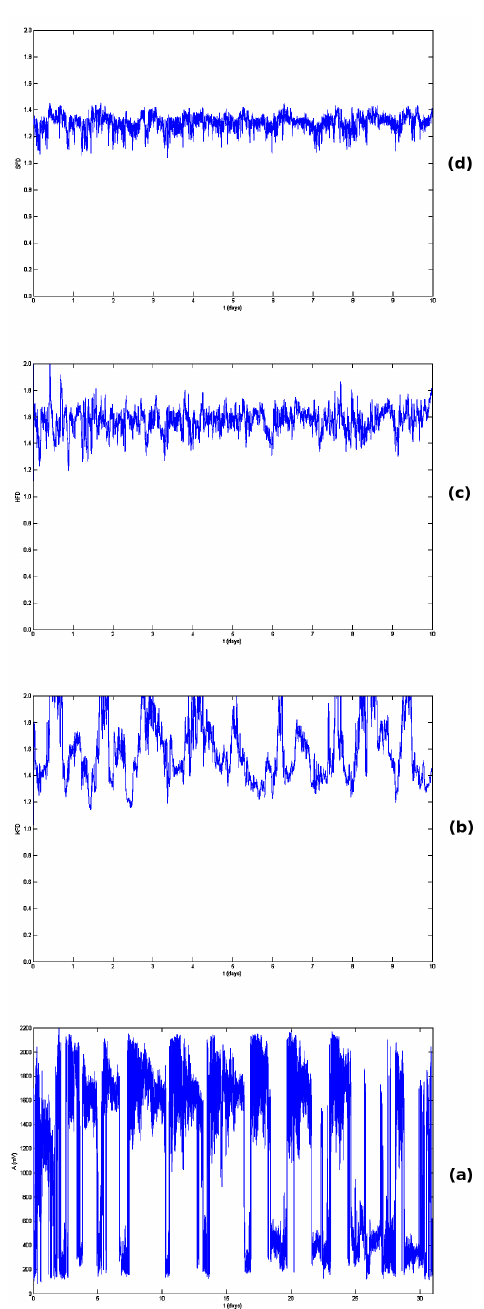
Figure 4. Results from fractal dimension analysis. From bottom to top: ( a ) The EM time series and the fractal dimensions according to the algorithms of ( b ) Katz (KFD) ; ( c ) Higuchi (HFD) and ( d ) Sevcik (SFD). Horizontal axis is in days from the beginning of measurements (2018 / 10 / 26). The measurement sampling rate is 1 s − 1